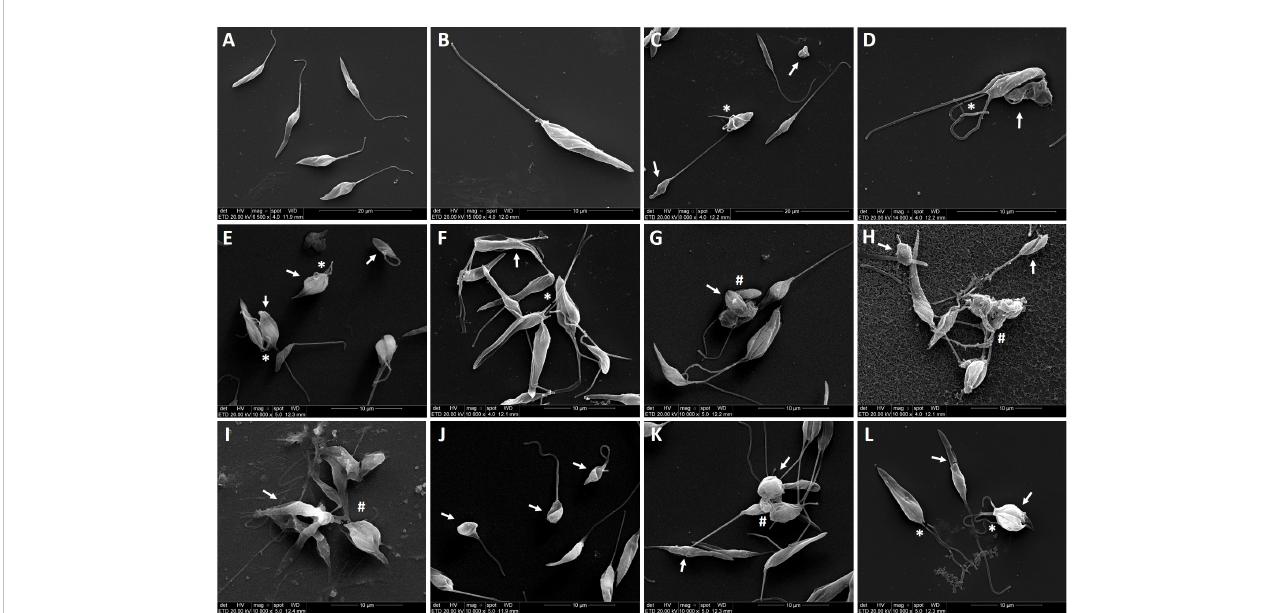
FIGURE 5 Scanning electron micrographs of L. amazonensis promastigotes treated or not with imidazolium salts at IC 50 values for 6 h. Untreated parasites showing the typical elongated shape (parasite body and anterior fl agella) (A, B) . Parasites treatment with amphotericin B at 0.4 µM (C, D) , C 10 MImMeS at 11.6 µM (E) , C 16 MImPF 6 at 6.9 µM (F) , C 16 MImBr at 6 µM (G) , C 16 M 2 ImCl at 4.1 µM (H) , C 16 M 4 ImCl at 1.8 µM (I) , (C 10 ) 2 MImCl at 1.9 µM (J) , C 16 MImMeS at 0.75 µM (K) and C 16 MImCl at 1.23 µM (L) . The images show alterations in promastigote body shape or disruption of plasma membrane (arrows), fl agellum loss (asterisks), and aggregation of cells (hashes). Bars: (A, C) represent 20 µm, (B) and (D – L) represent 10